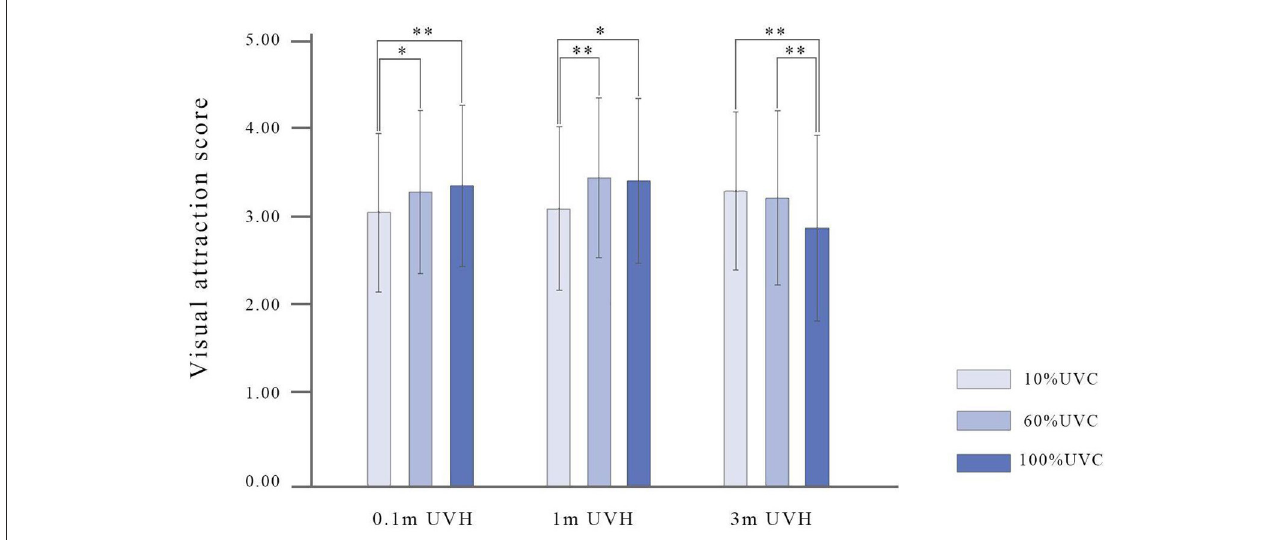
FIGURE10 The interaction of UVC and UVH on visual attraction. UVC, understory vegetation cover; UVH, understory vegetation height. * p < 0.05; ** p < 0.01.